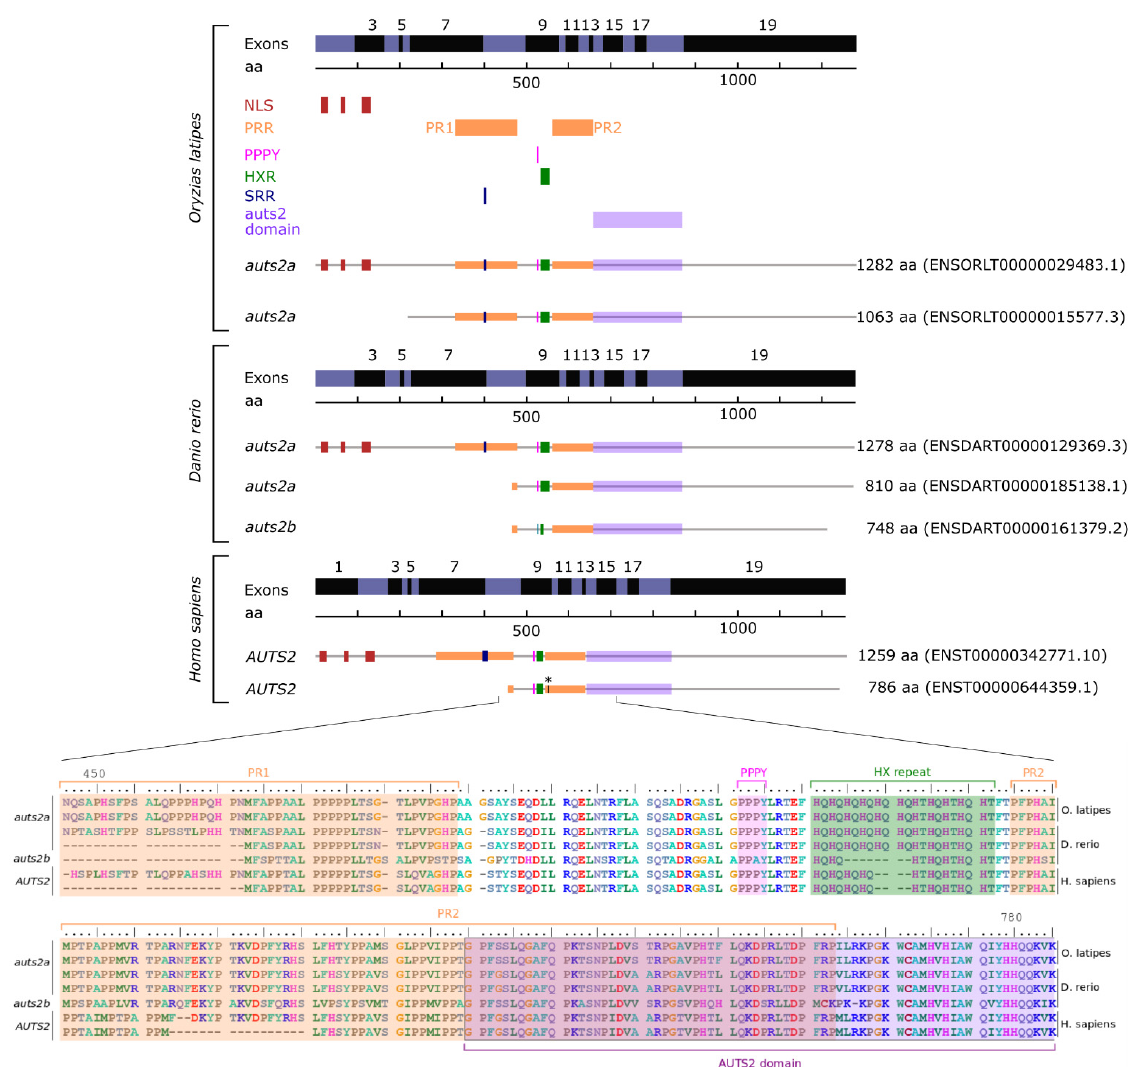
Figure 4. AUTS2 exons and protein domains in humans, zebrafish, and Japanese medaka based on Ensembl. NLS: nuclear localization sequence. PRR: proline-rich repeat domain. PPPY: PPPY protein binding motif. HXR: HX repeat motif. SRR: serine-rich repeat domain. * indicates the position of